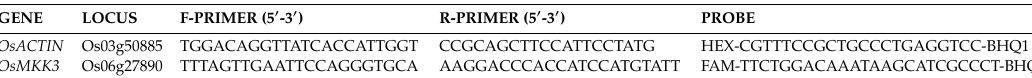
Table 1. qRT-PCR primers and